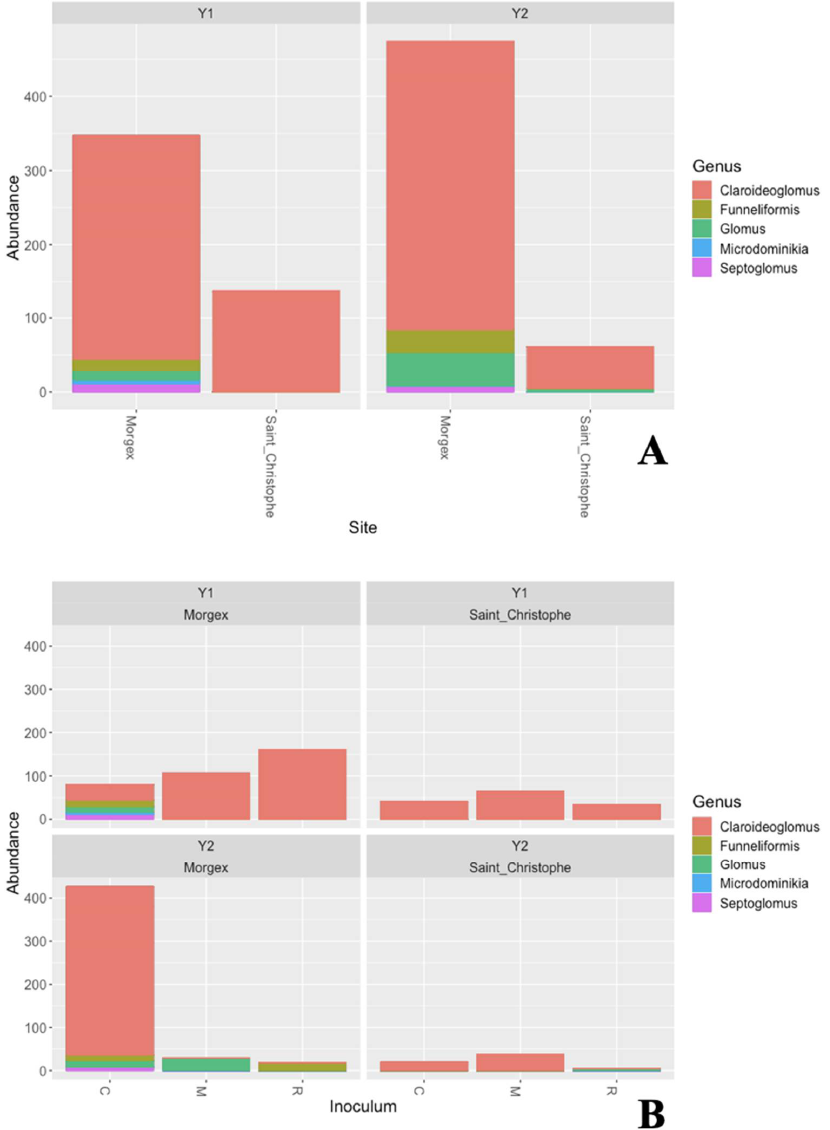
Figure 2. ( A ) Bar chart showing the taxonomic distribution (based on fungal ITS2), at genus level, of OTUs belonging to the phylum Glomeromycota, retrieved from Morgex, and Saint Christophe; ( B ) Bar chart showing the effect of the inoculum on the taxonomic distribution (based on fungal ITS2), at genus level, of OTUs belonging to the phylum Glomeromycota, retrieved from Morgex, and Saint Christophe. (Y1: year 1; Y2: year 2; C = Carrier (Control); R = Single-species inoculum ( Rhizophagus intraradices ); M = Multi-species inoculum ( R. intraradices and Funneliformis mosseae ).